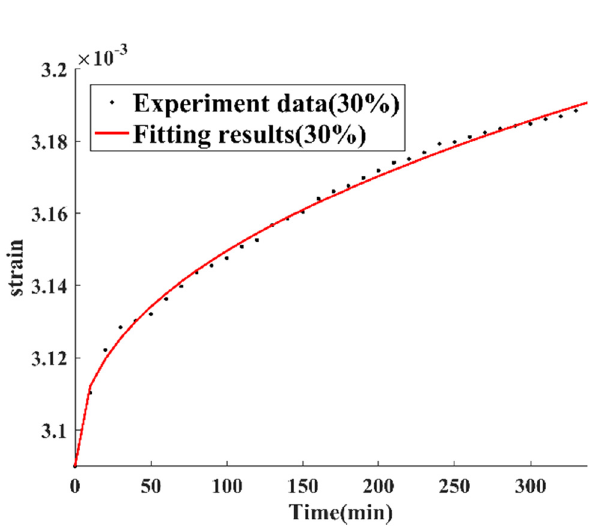
Figure 14: Fitting results based on the fractional de fi ned Maxwell model and 30% stress